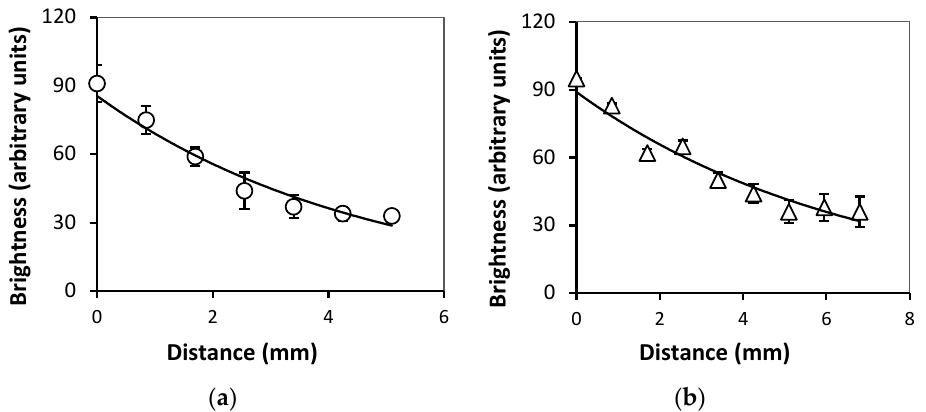
Figure 8. Dependences of maximal brightness inside the FGs on the distance from the upper gel/water boundary in PAAm/Xanthan sample ( a ) and PAAm/Guar sample ( b ). Vertical bars reflect the confidence interval with p = 0.01 ( n = 13). See also explanation in the text. Table 1 presents the results of the statistical analysis of the ultrasound visualization for ferrogels with the PAAm/Xanthan network with different content of embedded iron oxide MPs. Table 2 provides the same information for FGs with the PAAm/Guar network. In general, the increase of MPs content resulted in the enhancement of all echogenic pa- rameters in both series of ferrogels. The maximal brightness at the boundary and in the interior was reliably larger than the average values. The increase in the load of MPs was also accompanied with the enlargement of the standard deviation of the values of bright- ness. Most likely, it reflected the increase of the structural inhomogeneity inside FGs. Table 1. Results of the statistical analysis of the ultrasound visualization for ferrogels with PAAm/Xanthan network filled with different content of iron oxide MPs. The average values with confidence interval at a significance level of p = 0.01 ( n = 60) are present.